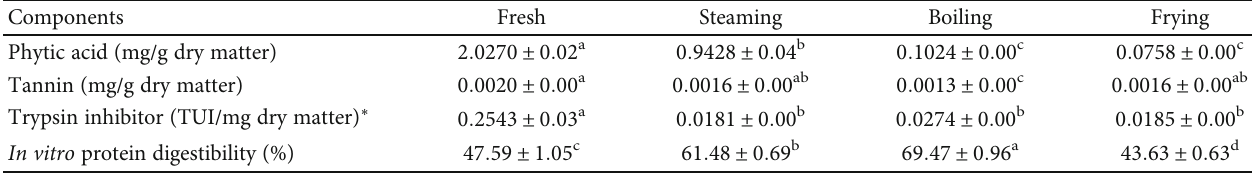
Table 4: Antinutritional components and in vitro protein digestibility of Kabau in di ff erent processing techniques. Components Fresh Steaming Boiling